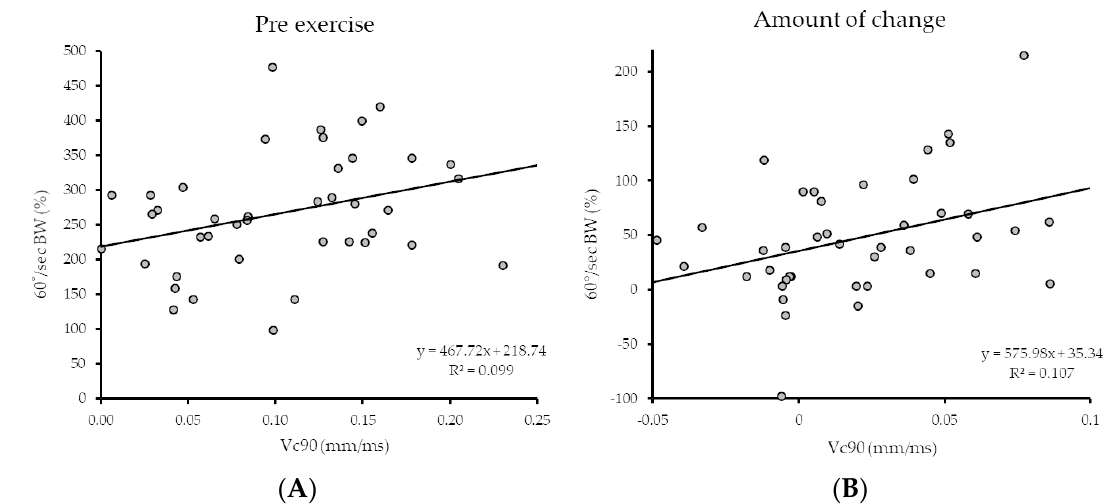
Figure 4. ( A ) Results of linear regression analysis of pre-exercise, ( B ) Results of linear regression analysis of Amount of change.